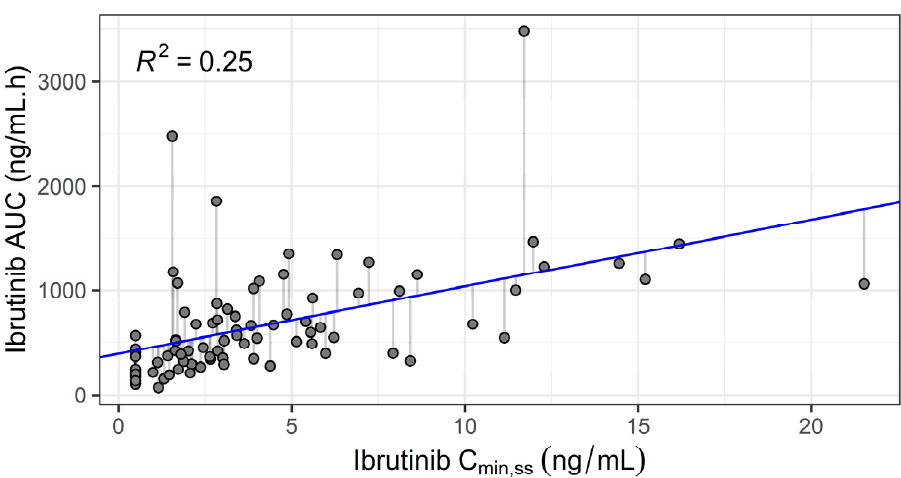
Figure 1. Ibrutinib actual area under the curve (AUC) vs. observed steady-state trough concentration. Solid line: linear regression ( n = 85 patients).